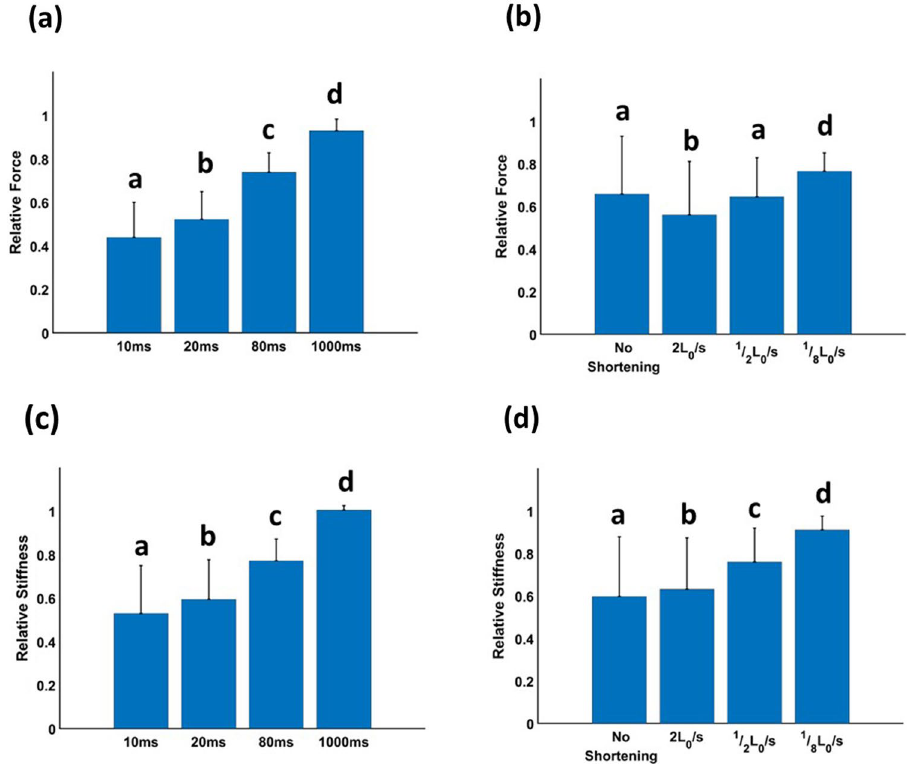
Figure 3. Mean values (+ 1 S.D.) of relative force ( a, b ) and relative stiffness ( c, d ) after different pause durations ( a, c ) and different velocities of active shortening ( b, d ). Mean relative force ( a ) and stiffness ( c ) represent mean values for all conditions including no shortening, 1/8L 0 /s, 1/2L 0 /s and 2L 0 /s, and mean relative force ( b ) and stiffness ( d ) represent mean values for all pause durations including 10, 20, 80, and 1000 ms. Mean relative force and stiffness increased with increasing pause duration and decreasing shortening velocity. Bars with the same letter are not significantly different (HSD, p > 0.05).